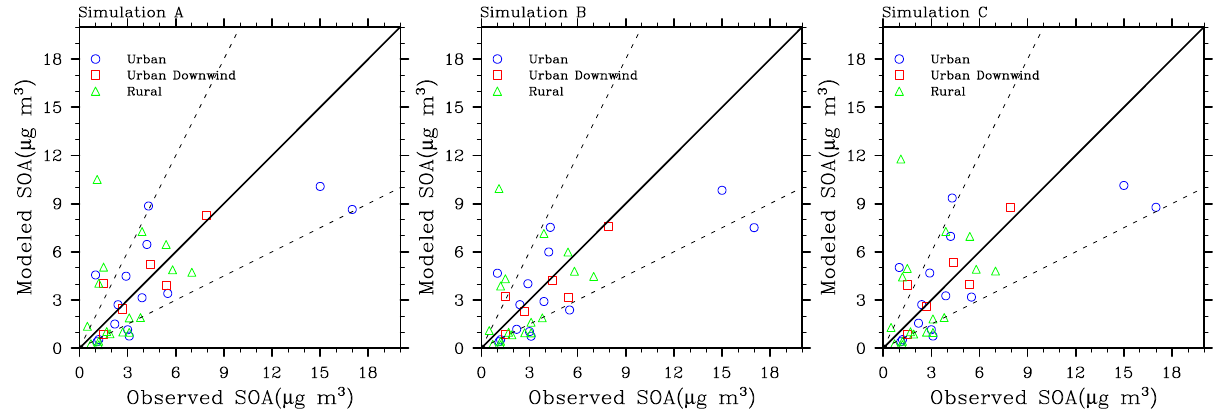
Fig. 7. Comparison of SOA mass concentrations observed at the urban, urban-downwind and rural sites reported in Zhang et al. (2007) with those simulated in Simulation A, Simulation B and Simulation C. Solid lines show the 1:1 ratio, and dashed lines show the 1:2 and 2:1 ratios. The measurements at the various sites were made in different seasons and different years between 2000 and 2006 and were reported for the average of varying durations spanning from 8 to 36 days. The model results are the average values over the same months as the